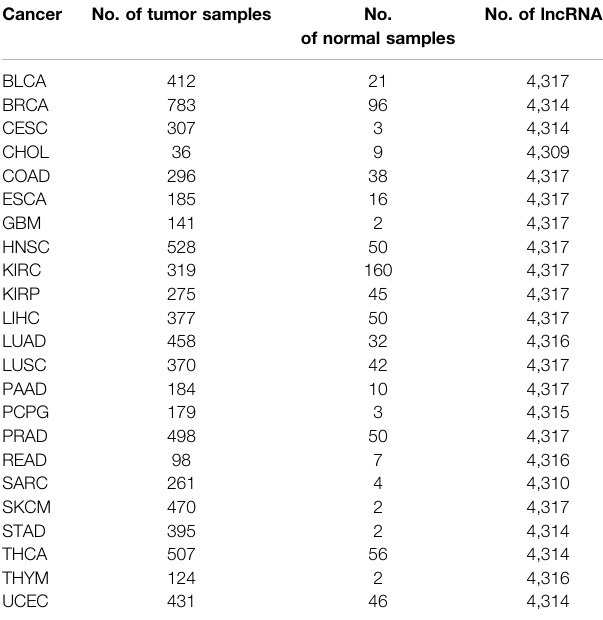
TABLE 1 | The number of samples and lncRNAs for each cancer in methylation data.